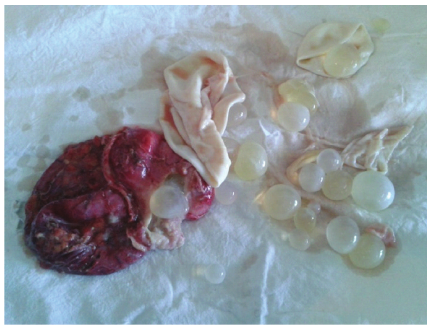
Figure 6: Specimen opened showing daughter